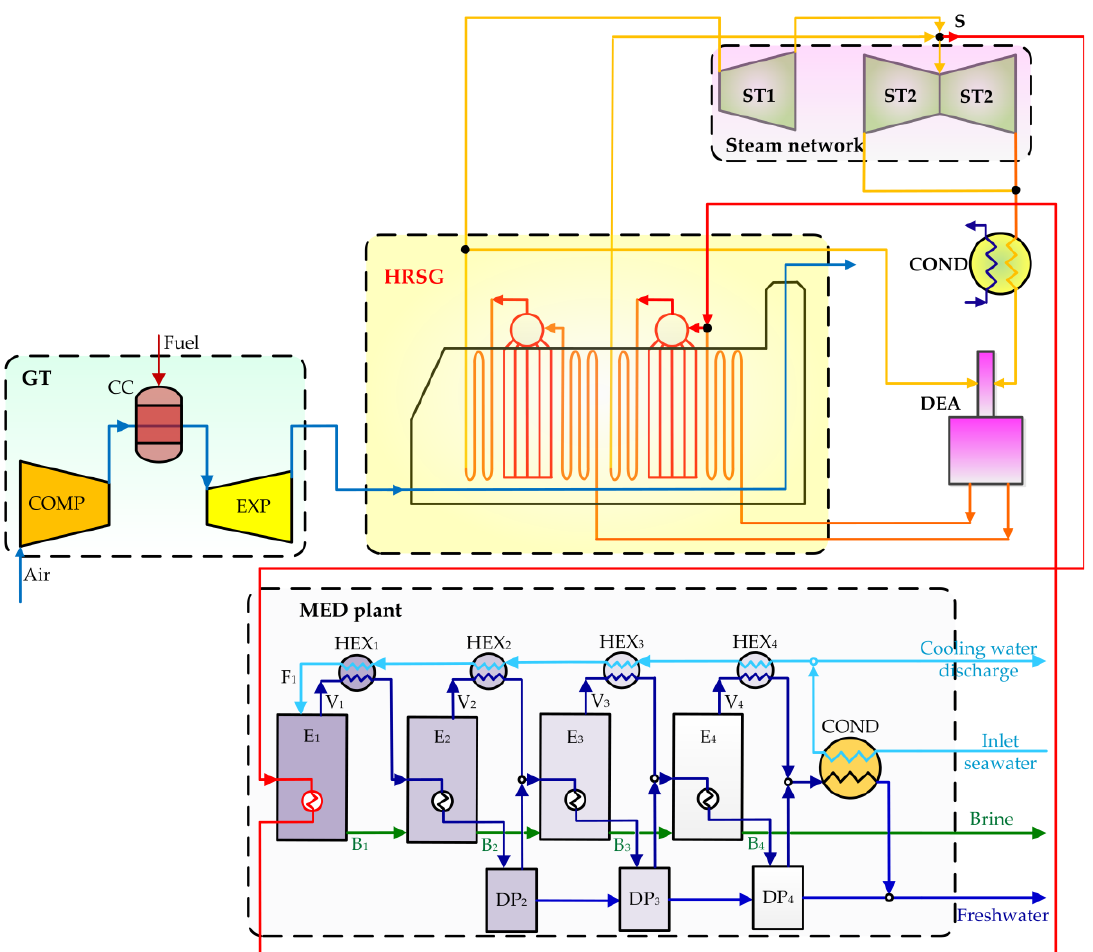
Figure 1. Dual-purpose power and desalination plant (DPPDP).